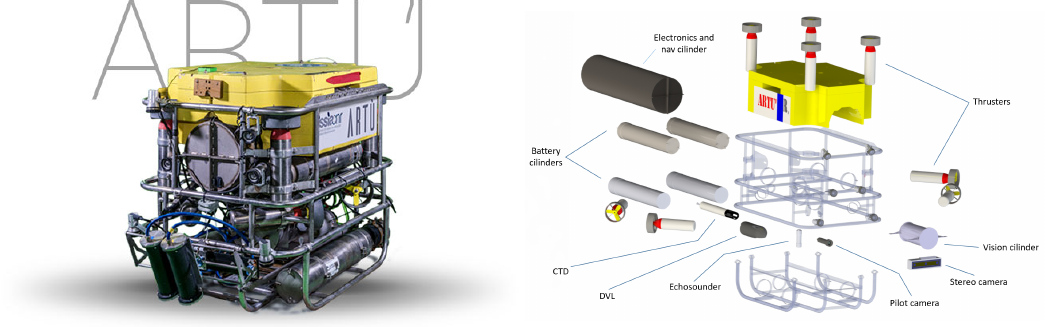
Figure 6. R2 (Artù) ROV. ( left ) a picture; ( right ) CAD design with sensors and